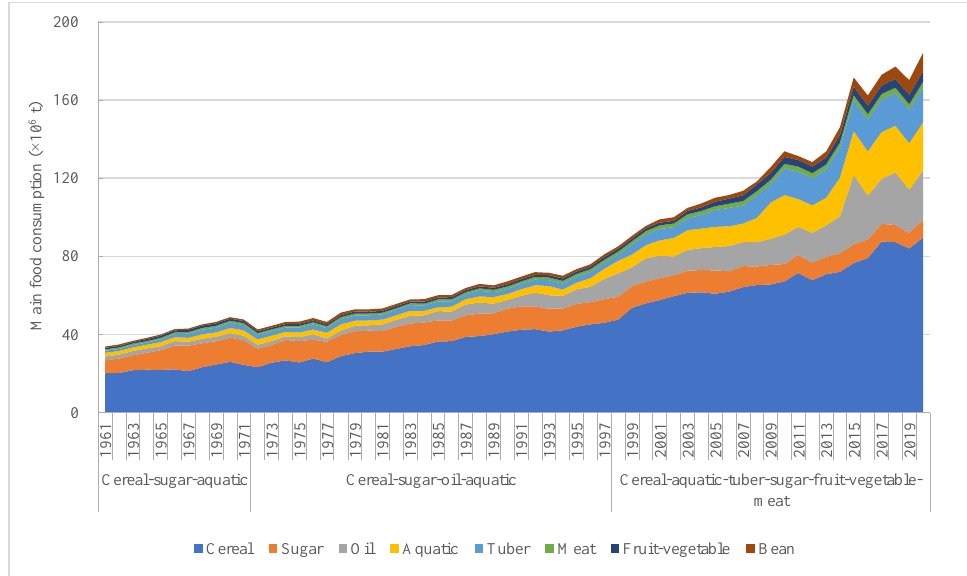
Figure 3. Change of main food consumption and its patterns.